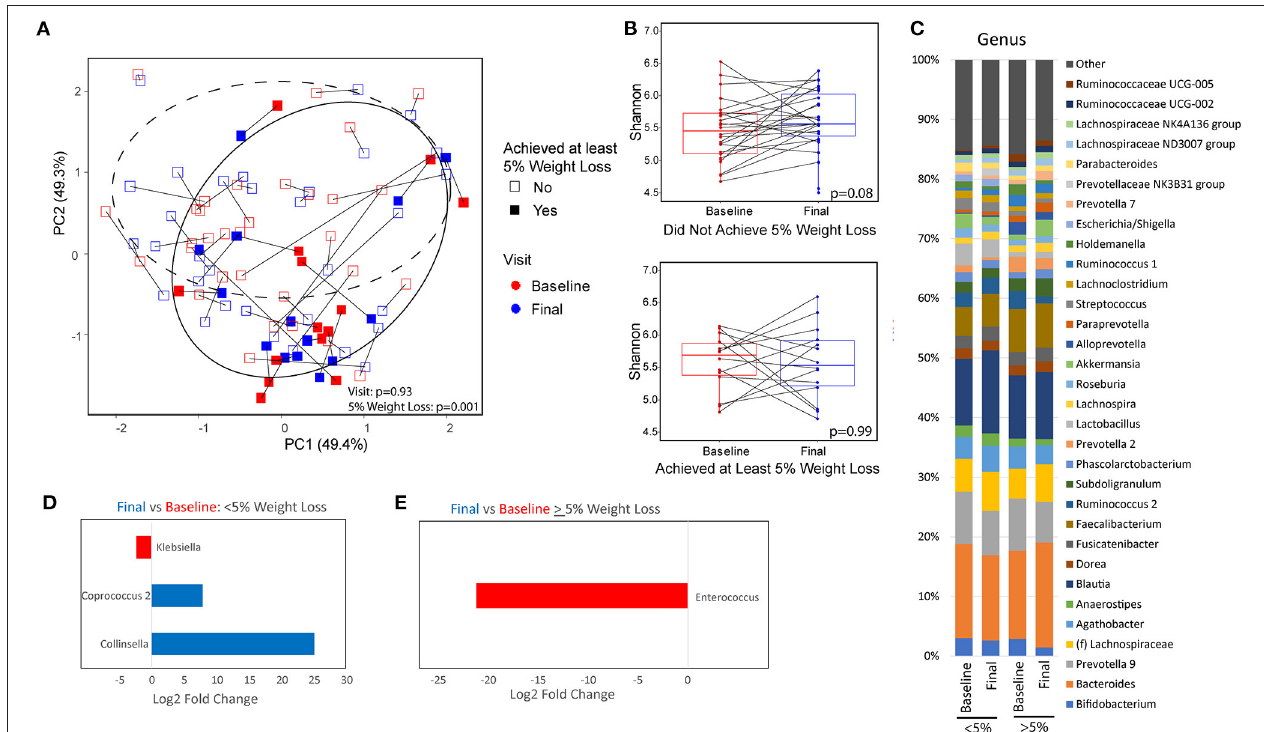
FIGURE 2 | Microbiome differences between baseline and after a calorie-restricted diet by weight loss category. (A) Principal coordinate analysis plot using the Robust Aitchison distance metric colored by visit with different shapes and 95% confidence interval ellipses corresponding to the amount of weight loss. Dashed ellipse encircles those that did not achieve at least 5% weight loss. Solid ellipse encircles those that did achieve at least 5% weight loss. (B) Microbial diversity as measured by Shannon index (measurement of species richness and evenness) between baseline and end of study, stratified by weight loss. (C) Taxonomic summary plots of genera stratified by timepoint and weight loss. Only genera with at least 1% relative abundance are listed. (D,E) Genera that are differentially abundant between baseline and week 16 for patients with (D) minimal weight loss and those with (E) at least 5% weight loss. Red indicates genera that are overabundant at baseline and blue indicates genera that are overabundant at the final visit. Magnitude of difference is represented as the log 2 of the fold change estimated from DESeq2